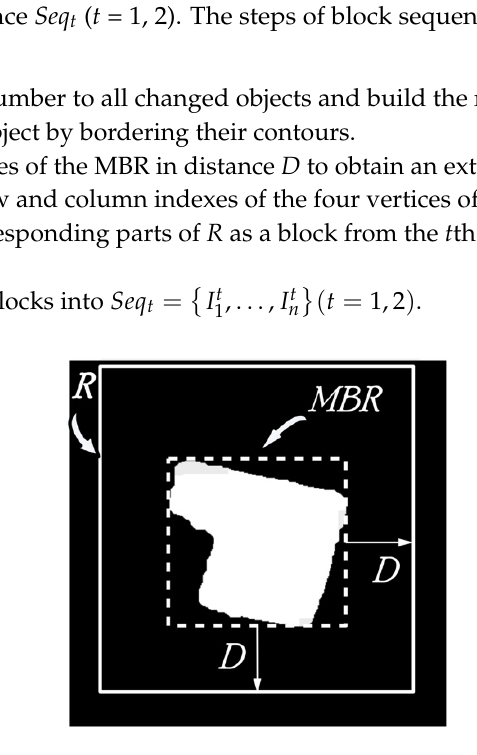
Table 1. Color and texture description operators.